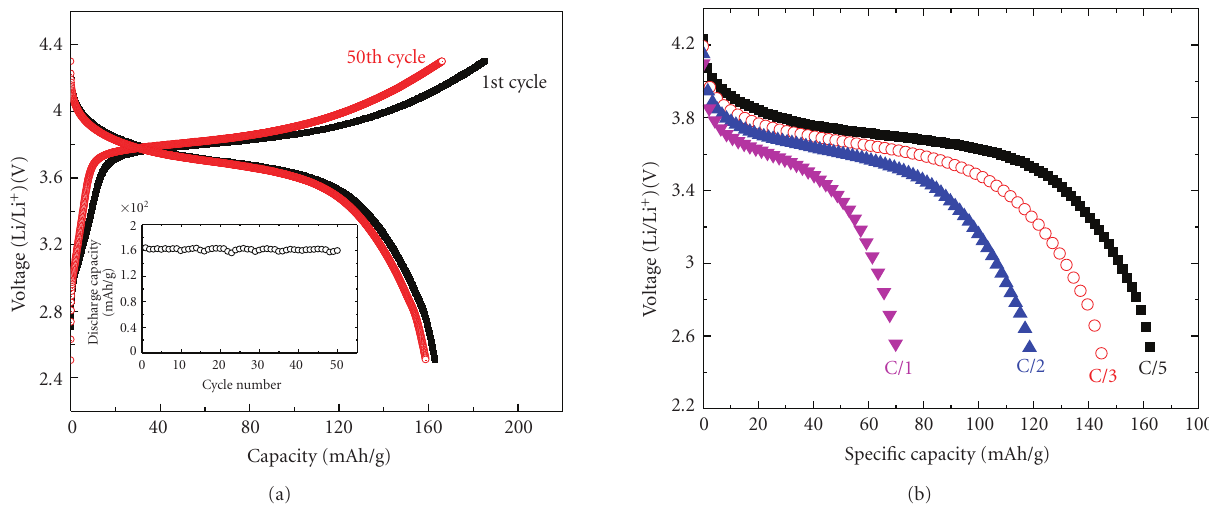
Figure 7: (a) Charge / discharge profile of LiFePO 4 sample with carbon source and inset discharge up to 50 cycles; (b) discharge profile of LiFePO 4 sample with carbon source at discharge rate of C/5, C/3, C/2, and 1C.